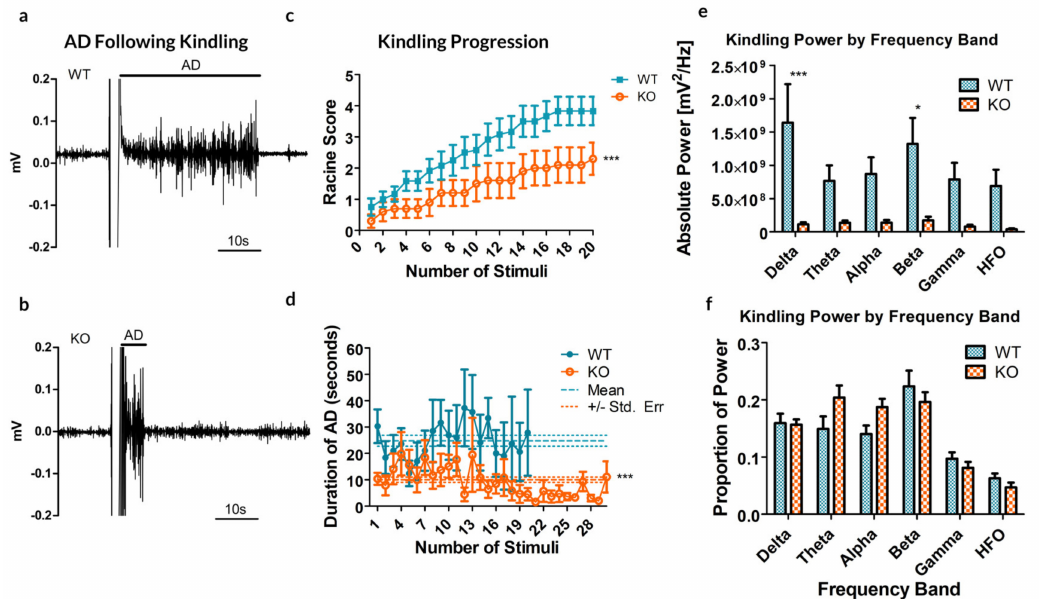
Figure 2. Results from the kindling of 12 Panx1 +/+ (WT) and 10 Panx1 − / − (KO) mice. ( a , b ) Sample recordings of the CA3 following electrical stimulation to induce kindling in WT ( a ) and KO ( b ) mice, demonstrating the di ff erence in the afterdischarge (AD). These examples are reflective of the stimulus experienced by each mouse. ( c ) The maximal behavioral outcome experienced, as measured by the Racine score, averaged by group. A significant decrease in cumulative AD was observed in KO animals as compared to their WT counterparts. ( d ) The average duration of ADs following each stimulus showed no significant trial-dependent trends but strongly indicated a reduced AD duration in KO mice. Dashed lines show the mean AD duration and dotted lines represent the standard error of the mean (SEM). ( e ) Kindling power by frequency band. Significant di ff erences are reported by band, between the WT and KO groups ( f ) Percent total power by frequency band. * p < 0.05, *** p < 0.001, Student’s t